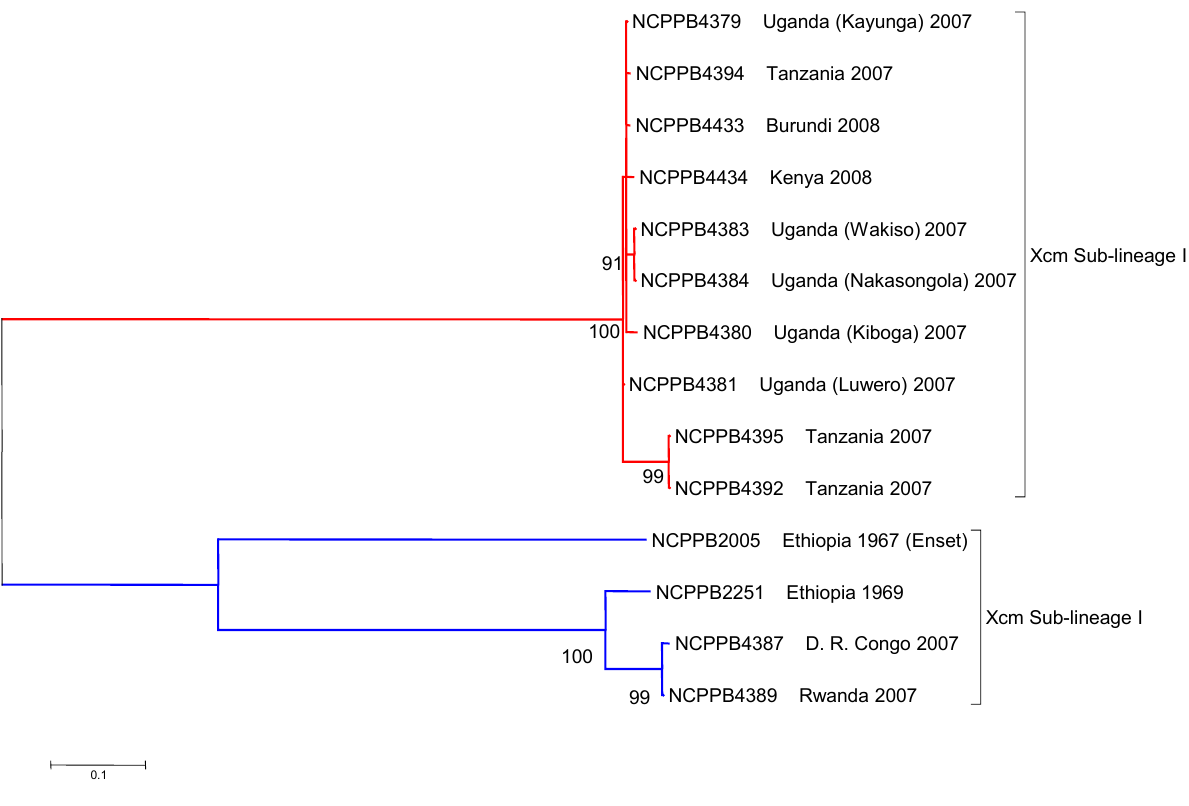
Figure 2. Isolates of Xcm from Burundi, Kenya, Tanzania and Uganda comprise a separate sub-lineage that is distinct from isolates from and D. R. Congo, Ethiopia and Rwanda. A maximum likelihood phylogenetic tree was generated as described in the Experimental Section. The position of the root was inferred from the phylogeny presented in Figure 1. The tree is based on 272 SNPs in 14 taxa. Branch lengths are drawn to scale and measured in the number of substitutions per site. Bootstrap values are given as percentages from 500 bootstrap trials.